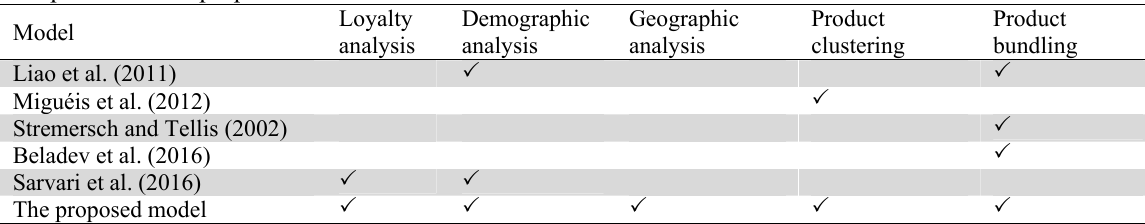
Comparison of the proposed model with similar works